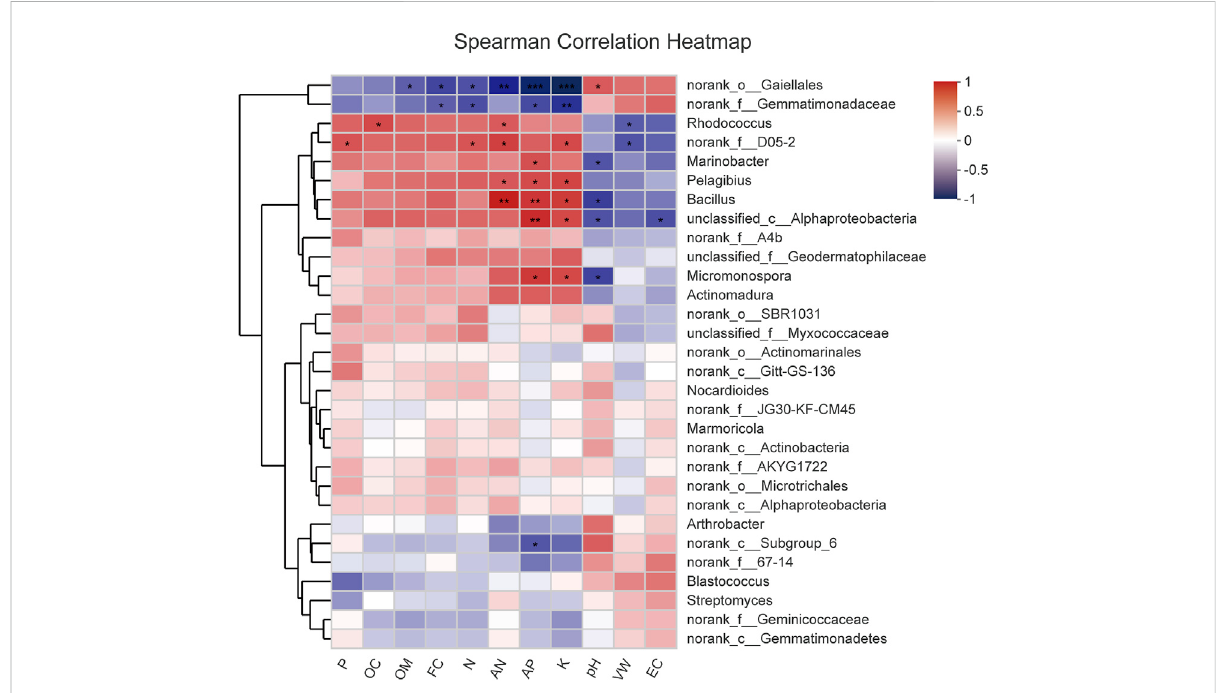
FIGURE 8 Heatmap of correlation of the top 30 abundant genera and environmental parameters. *Correlation is signi fi cant at the 0.05 level (two-tailed). **Correlation is signi fi cant at the 0.01 level